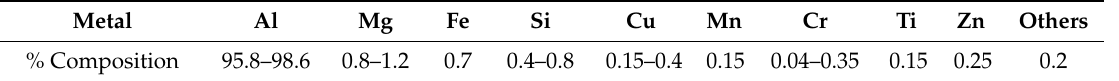
Table 1. Powder characteristics of the as received